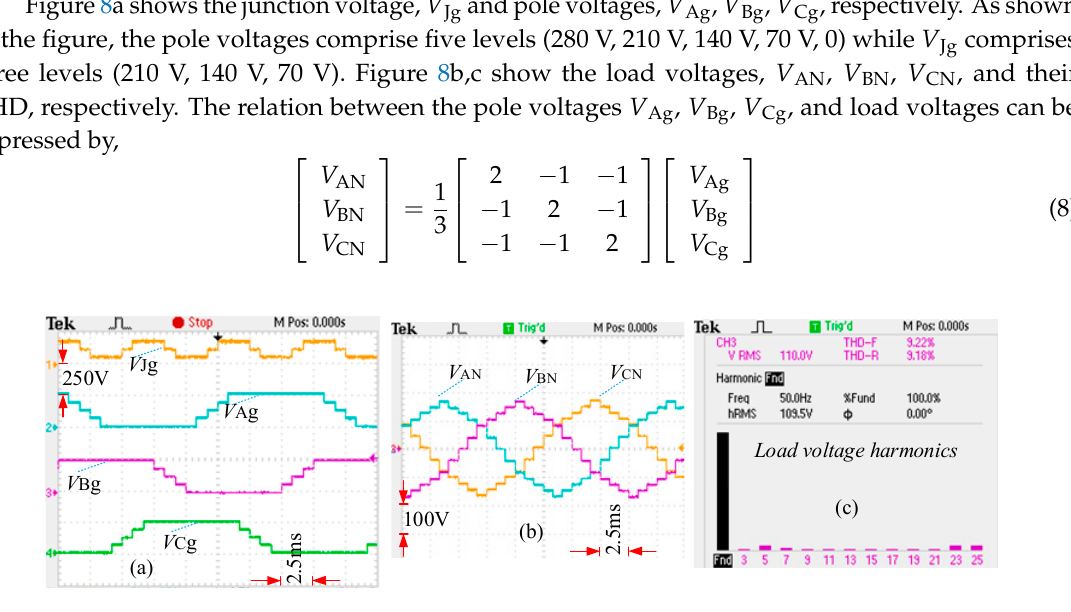
Figure 8. Experimental results of ( a ) Junction voltage, and Pole voltages when the CHB-cells are fed by symmetric dc-power supplies; ( b ) load voltage; ( c ) load voltage harmonics.